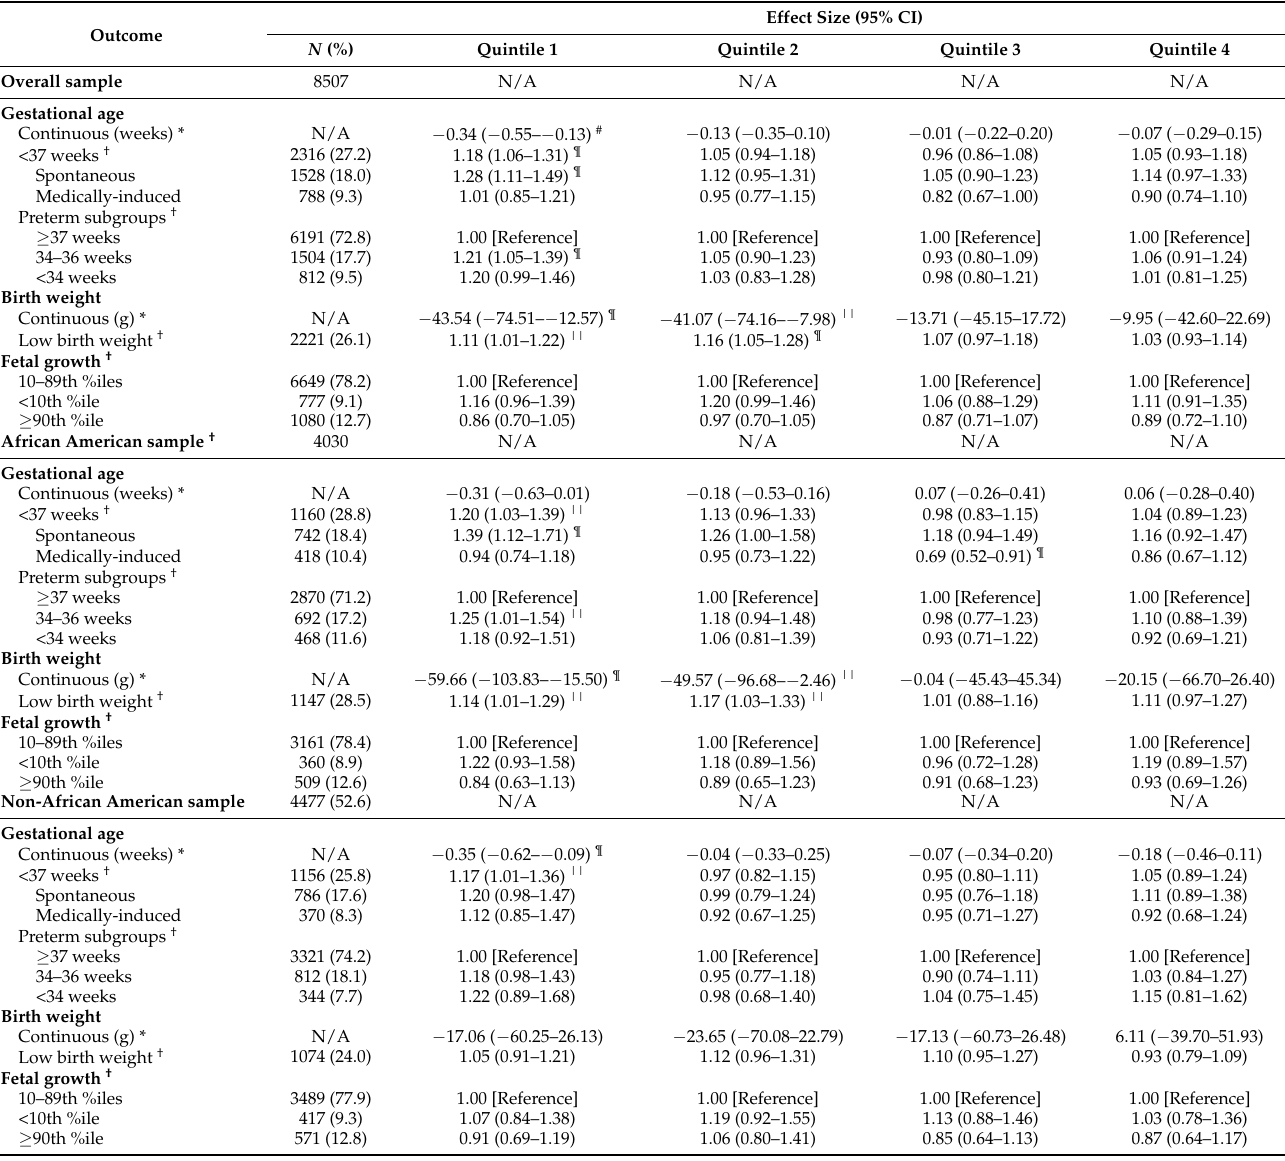
Table 2. Adjusted association between MSDS quintiles and pregnancy outcomes in the Boston Birth Cohort, relative to quintile